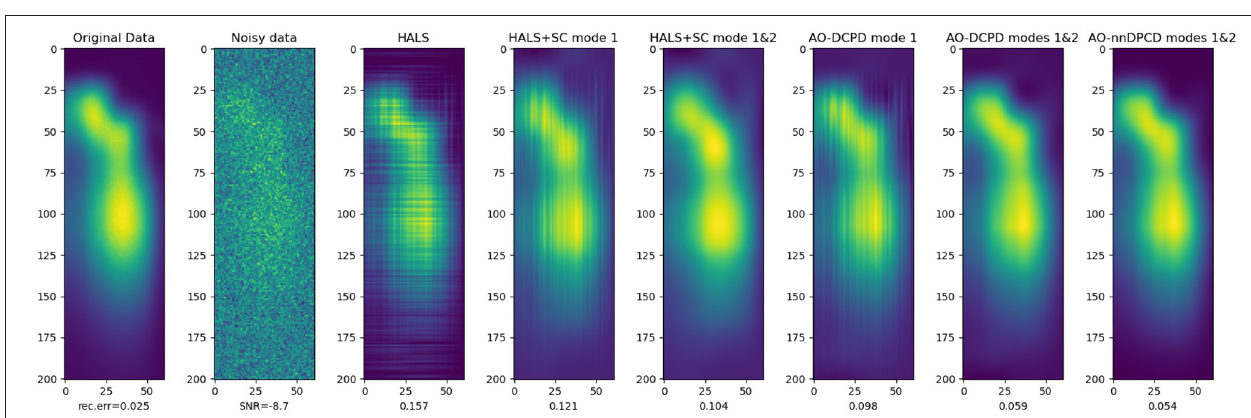
Frontiers in Applied Mathematics and Statistics |